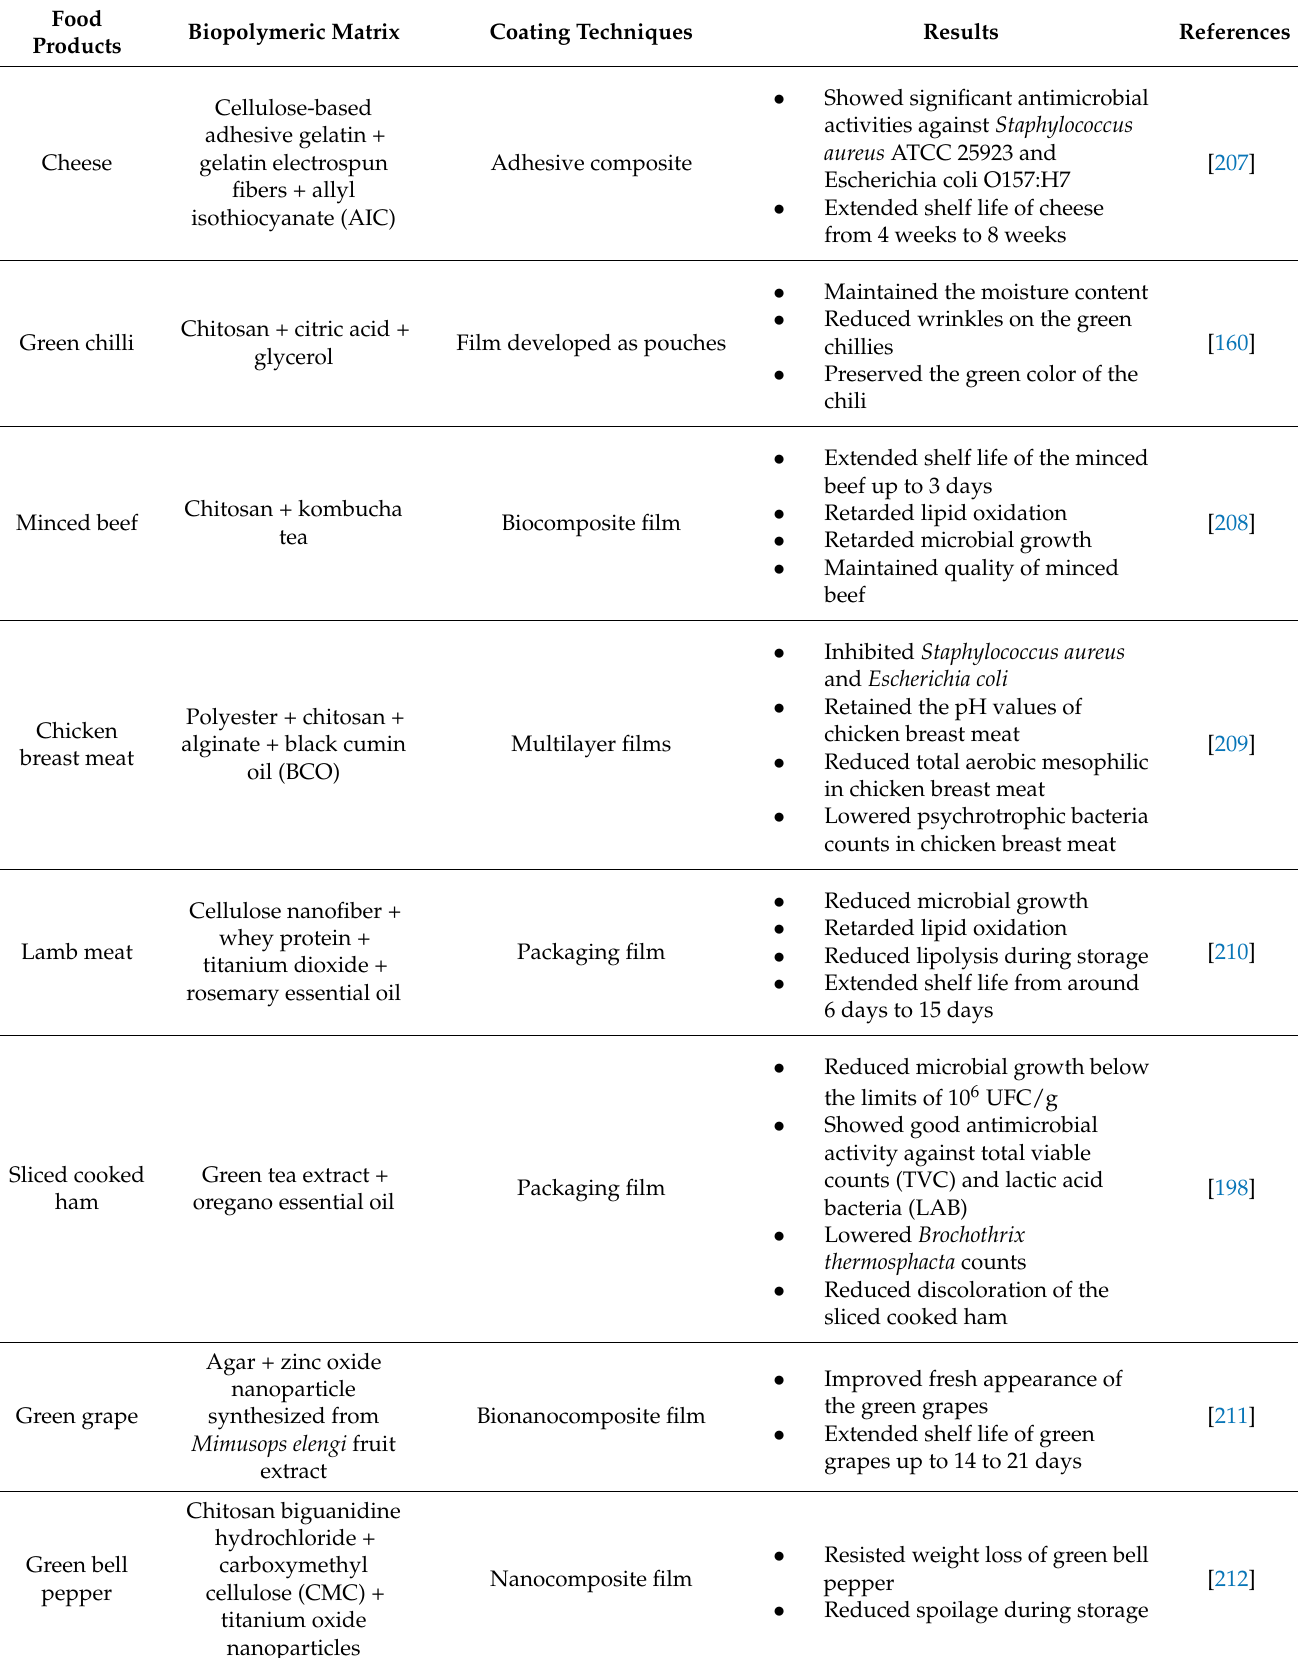
Table 4. Application of active packaging in food